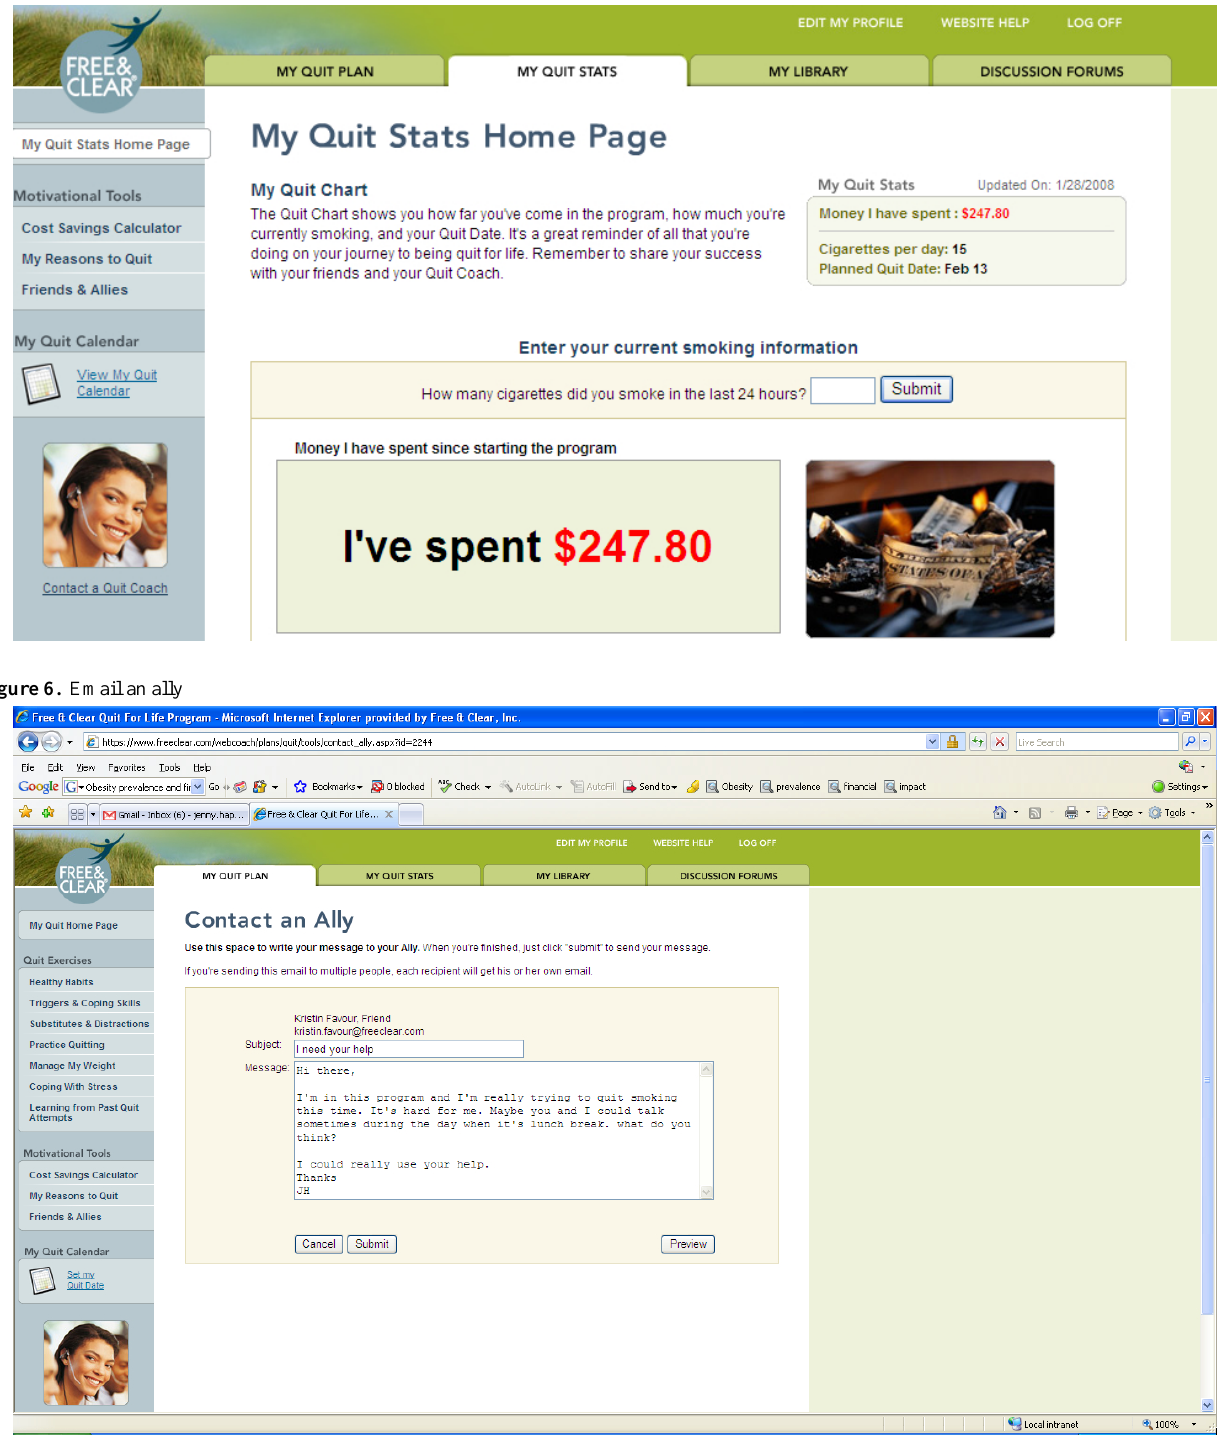
Figure 5. Progress tracker and cost calculator